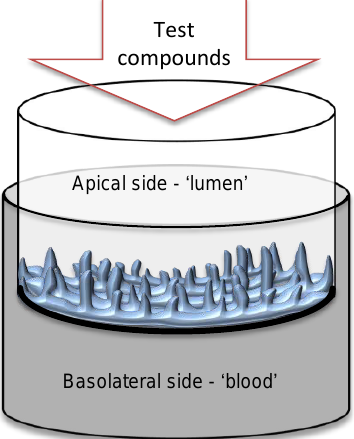
Figure 1. Scheme of the EpiIntestinal 3D human tissue cultivation in the insert with polycarbonate semipermeable membrane. Enterocytes face the apical side ´ lumen,’ while the basolateral side of the epithelium faces the ´blood´ medium.